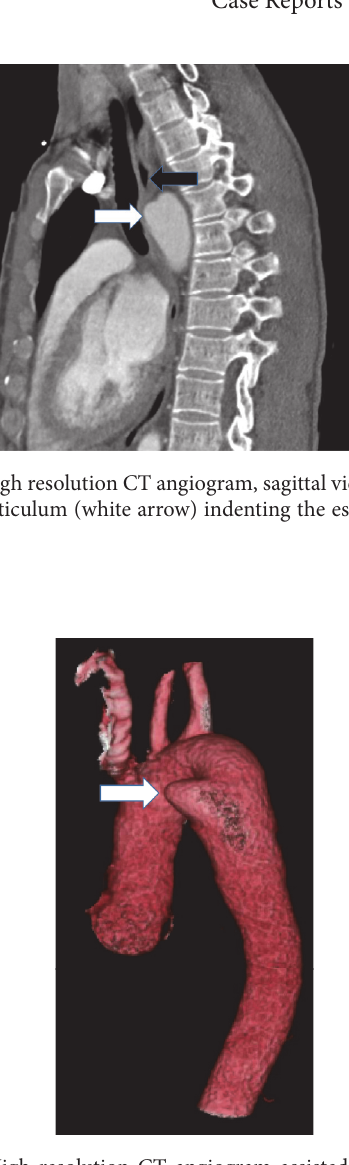
Figure 4: High resolution CT angiogram assisted 3-dimensional reconstruction of the arch of aorta showing the ductus diverticulum (white arrow).